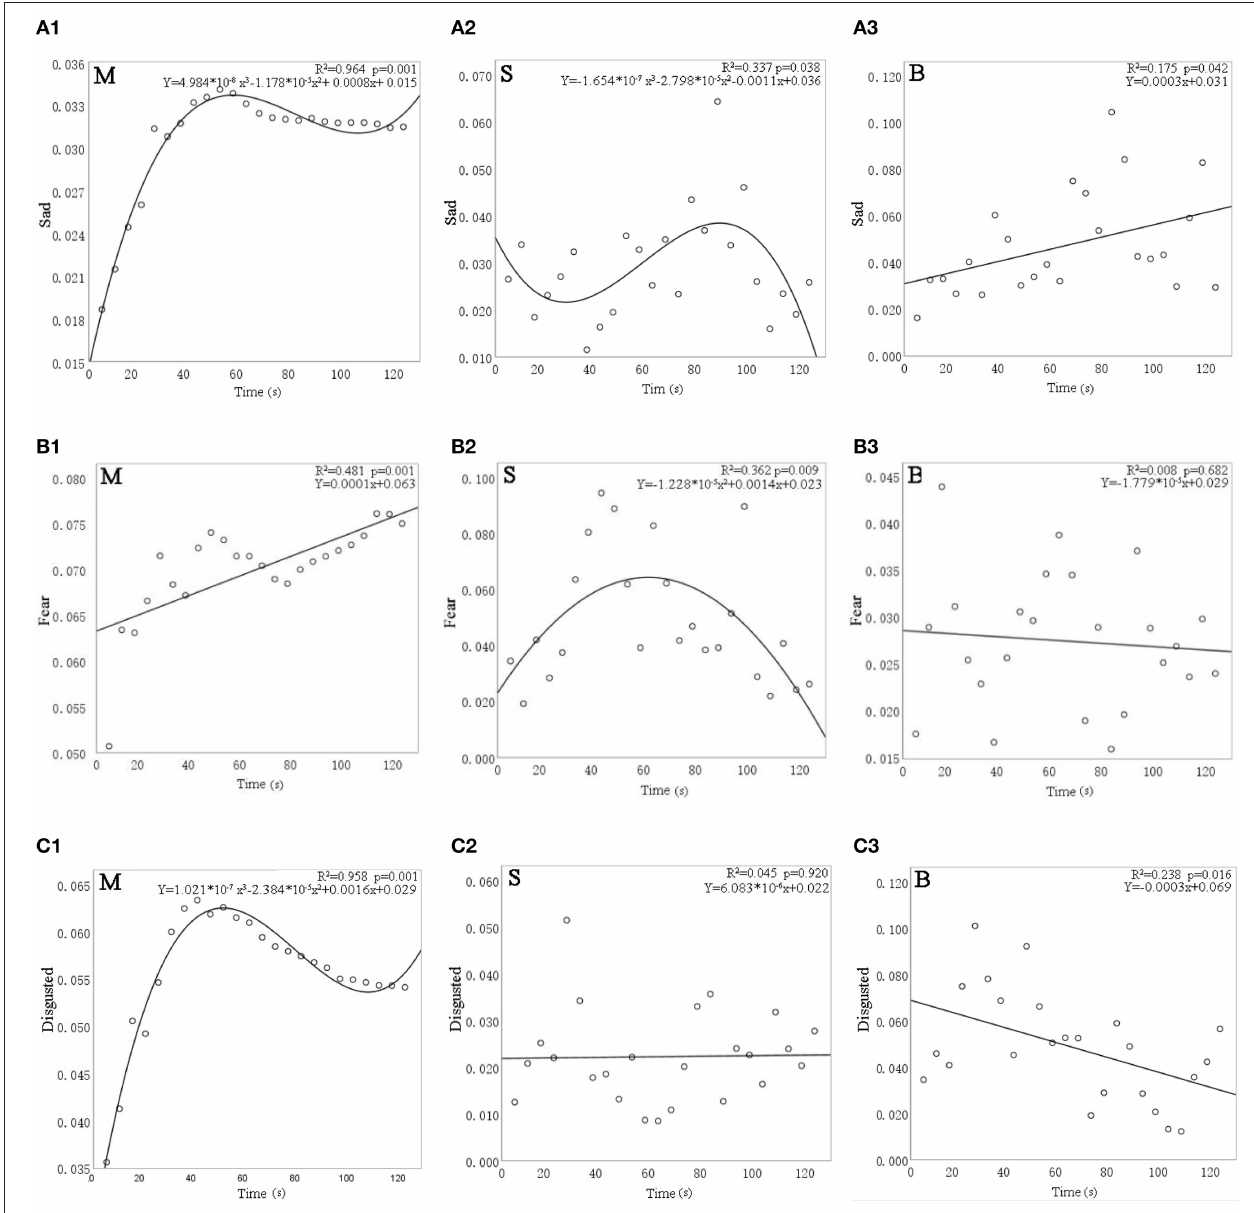
FIGURE 8 | The relationship between facial expression indices— (A) sadness, (B) fear, and (C) disgust—and time for different sound interventions. M, music; S, stream; and B, birdsong.